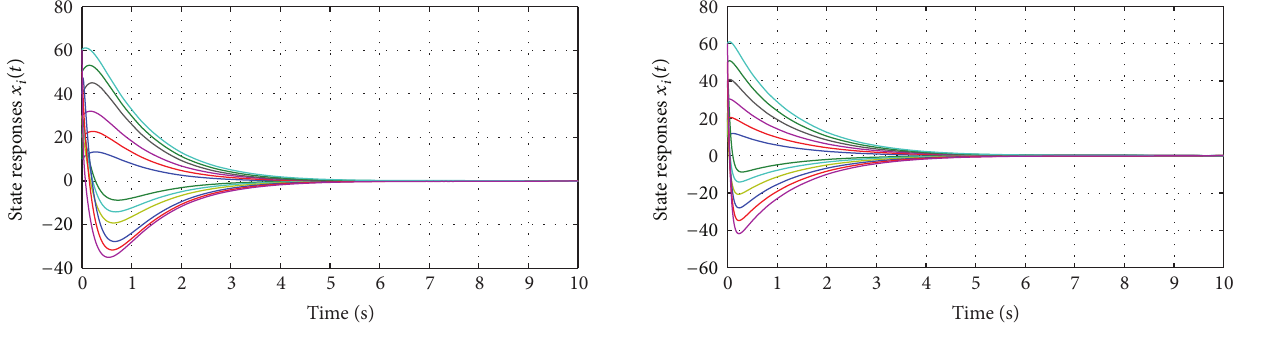
Figure 4: The state trajectories of six agents with topology G 3 .